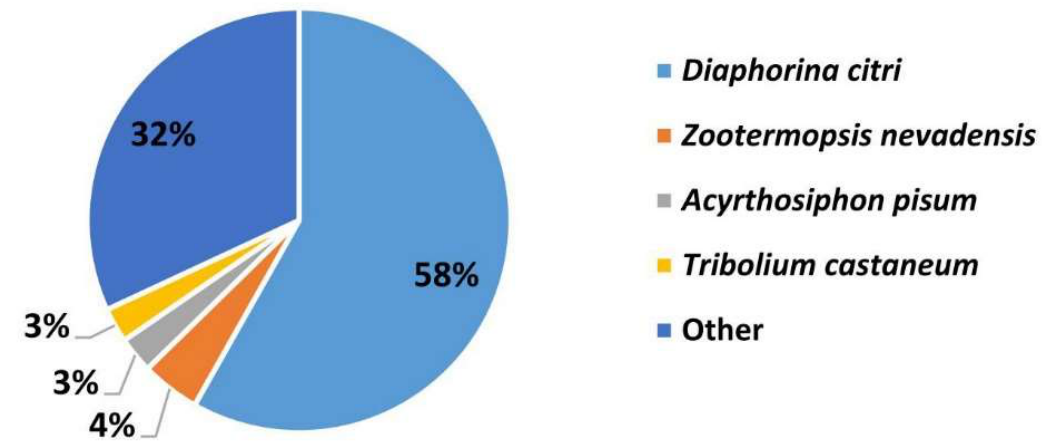
Figure 2. Percentage of homologous hits of the C. chinensis transcripts to other species. Blastx searched the C. chinensis transcripts against the non-redundancy protein database with a cut-off E-value of 10 −5 . Species that have more than 3% matching hits to the C. chinensis transcripts are shown.